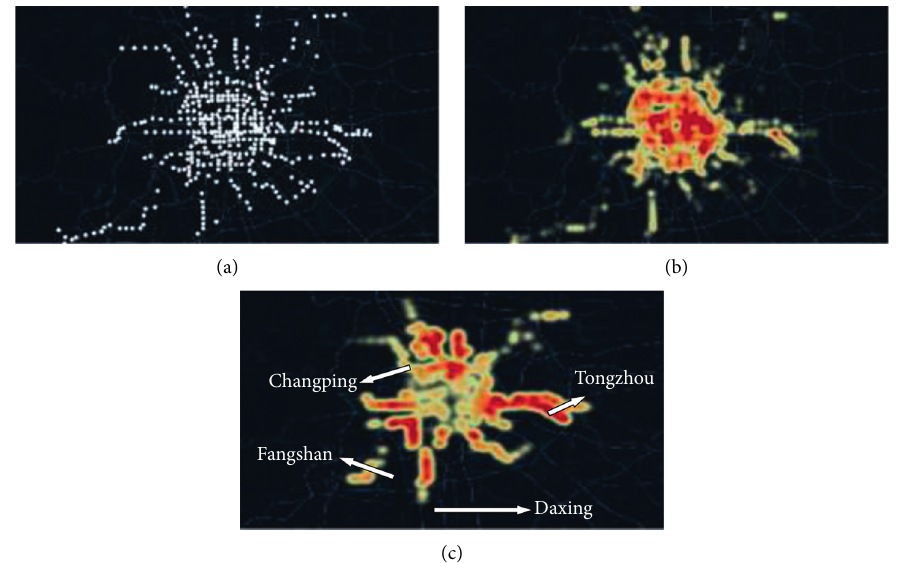
Figure 5: Comparison of weighted POIs and raw POIs. (a) The distribution of metro stations. (b) The distribution of raw POIs within 500meters of metro stations. (c) The distribution of weighted POIs within 500meters of metro stations.